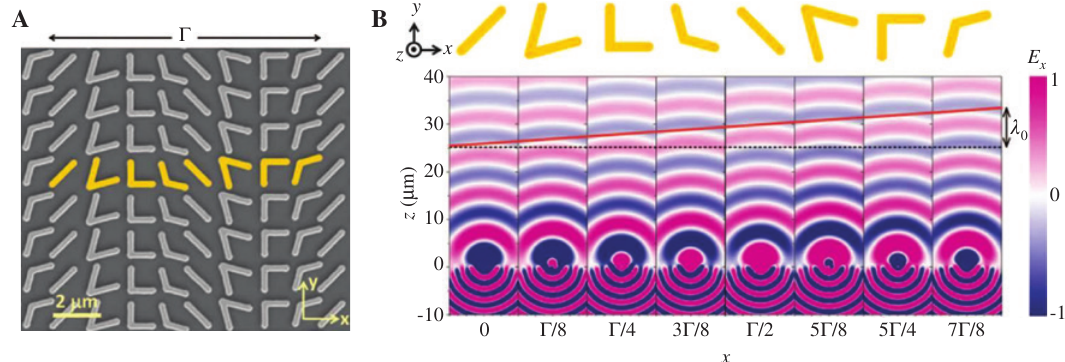
Figure 6: (A) The SEM image of metasurface based on the V-shape antennas. (B) The scattered electric field corresponds to the individual antennas in the left picture. Adapted from Ref.